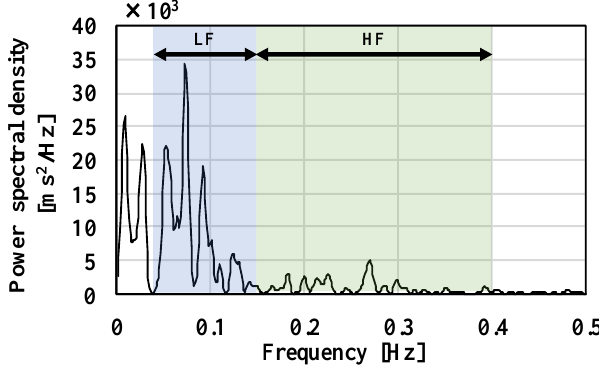
Figure 5. Frequency analysis of RRI time history.